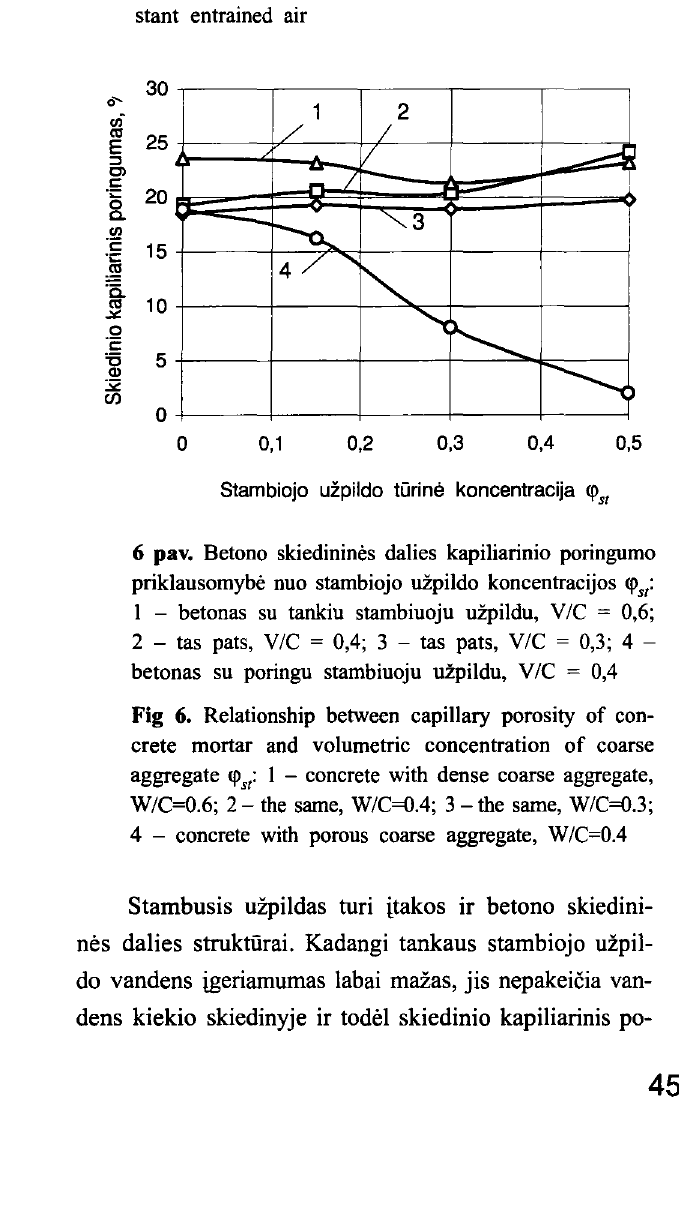
Fig 5. Relationship between compressive strength of concrete (W/C=0.4) and volumetric concentration of coarse aggregate (expanded clay aggregate) <ps 1: 1 - con crete with current entrained air; 2 - concrete with con